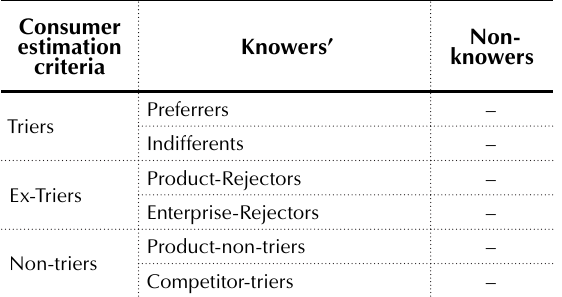
Table 1. Adapted Scandinavian “map of the